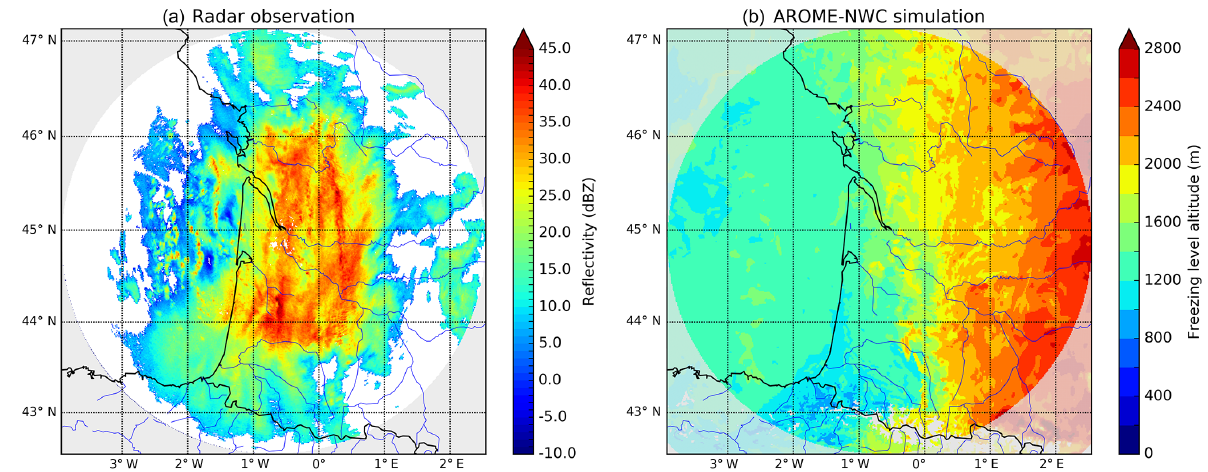
Figure 10. Same as Fig. 5 for 3 March 2017 at 21:00UTC on the radar of